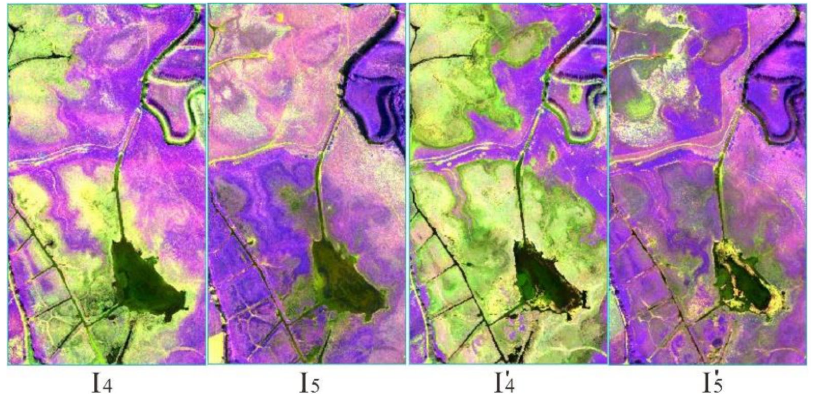
Figure 5. Visual effect of training and testing images in second set of experiment ( I 4 and I 5 show visual effect of training image; I (cid:48)